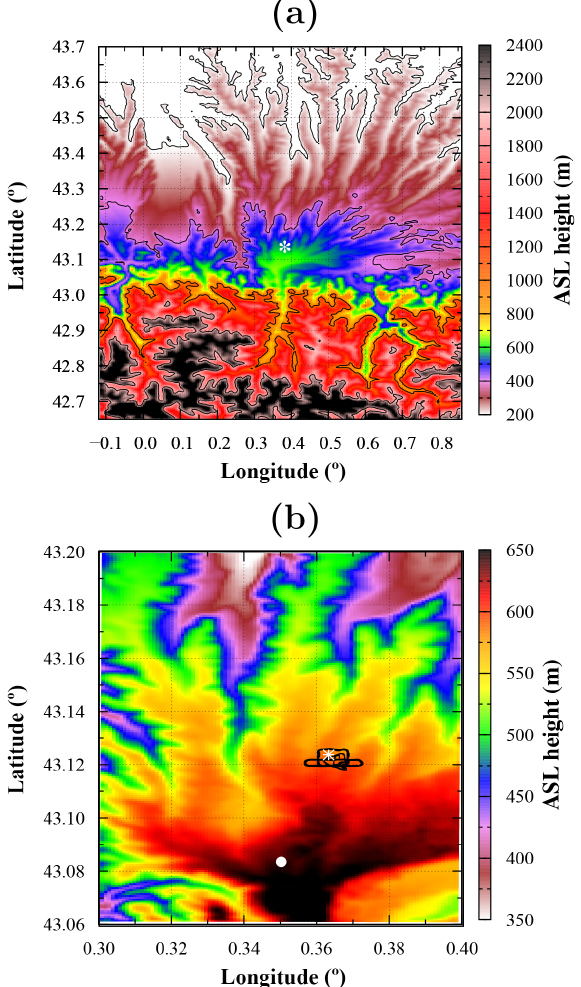
Figure 1. (a) Topography of the inner domain of the mesoscale sim- ulation which covers the Pyrenees (mountains and foothills). The plateau where Lannemezan is placed is coloured in green and the Aure valley is at the south. Topography lines are labelled at 200, 400, 1000 and 2000m (above sea level, a.s.l.). (b) Zoom of (a) over the plateau where Lannemezan is placed together with the M 2 AV flight tracks (black lines). The location of Site 1 (60m tower, UHF radar and GRAW soundings) and Site 2 (frequent radiosoundings, MODEM) are indicated with an asterisk and a dot respectively.